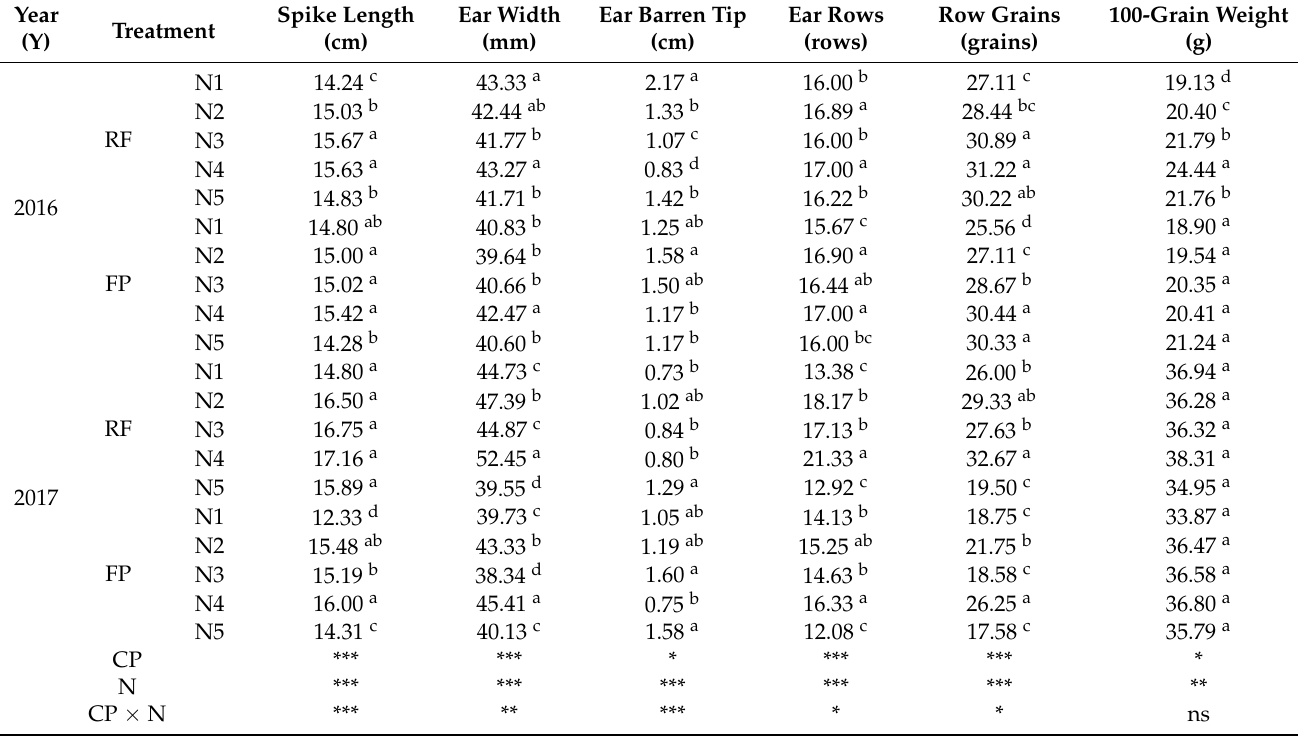
Figure 6. Effects of different treatments on evapotranspiration (ETa). N1, NO3 − :NH4 + ratios of 1:0; N2, NO3 − :NH4 + ratios of 1:1; N3, NO3 − :NH4 + ratios of 1:3; N4, NO3 − :NH4 + ratios of 3:1; N5, urea. Bars showed mean values plus one standard error ( n = 3). Different letters above the bars indicated that a significant difference was at p < 0.05 according to an LSD test. Table 5. Effects of different treatments on various yield components of the harvested